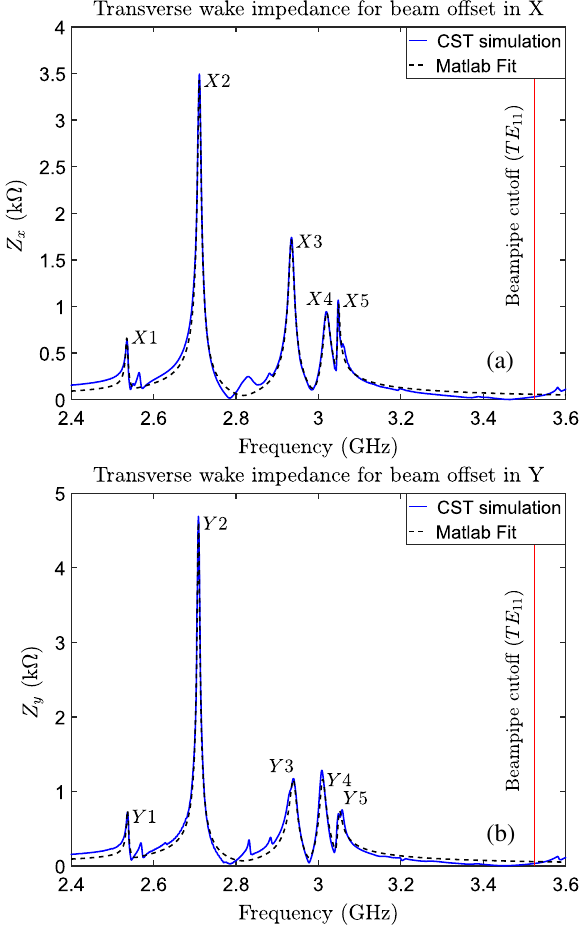
FIG. 5. Transverse impedance calculated by CST Particle Studio for the electron beam displaced in the X direction (a) and the Y direction (b) by 6.35 mm. The ten most dangerous modes correspond to the biggest peaks in